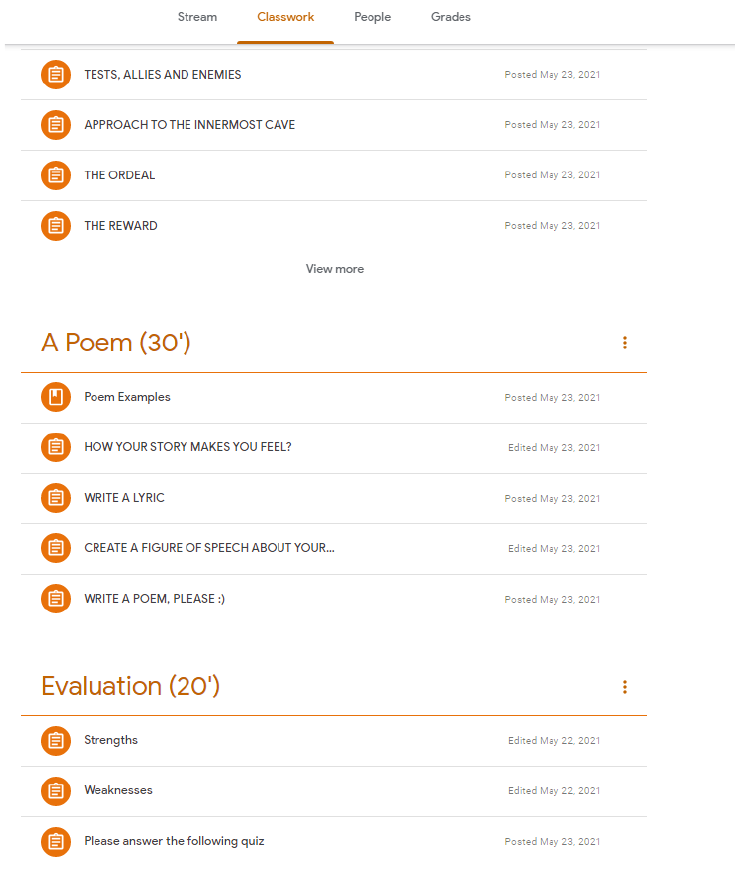
Figure 3. Google Classroom, classwork (second part).